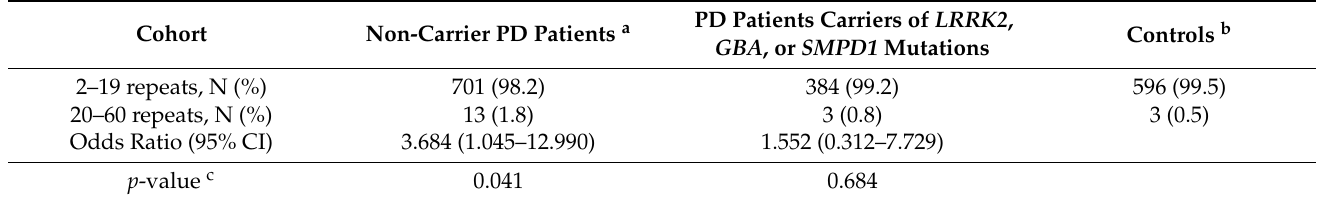
Table 2. The association 2–60 C9orf72 hexanucleotide repeats with Parkinson’s